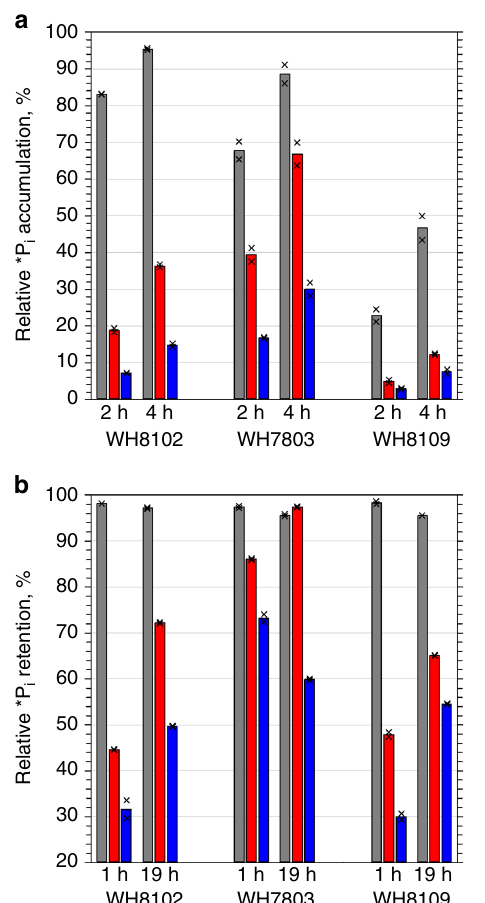
Fig. 4 Accumulation and retention of the accumulated *P i by Synechococcus . a The total P i accumulated in live cells (grey bars) compared with the amount of P i in PFA- fi xed cellular macromolecules (red bars) and TCA-precipitated nucleic acids (blue bars). Cells washed to remove the free P i were re-suspended in ASW-P i , supplemented with 100 Bq ml − 1 of H 3 32 PO 4 , incubated under standard cultivation conditions and sampled after 2 and 4 h. b Retention of the total accumulated P i in *P i pre- labelled cells and its internalization into macromolecules and nucleic acids. The pre-labelled cells re-suspended in ASW-P i were incubated under standard cultivation conditions and sampled after 1 and 19 h. The plots show the results of representative experiments. Bars present mean values of technical duplicates indicated as crosses. Horizontal grey lines indicate major ticks of the Y-axis to assist comparing values. Source data are provided as a Source Data fi le. (Fig. 7), i.e., ASW diluted 1:10 – 1:100, phosphate-buffered saline P i accumulation by cultured Synechococcus cells, we compared the or DW (Supplementary Table 8), which release periplasmic cell CCCP effect with the effect of three other metabolic inhibitors contents 27,39 but do not cause osmotic cell lysis of marine (Supplementary Table 7) on P i acquisition by oceanic bacter- Synechococcus (Fig. 5). Hypotonic washes reproducibly removed ioplankton to safeguard from potential artefacts. A similar time an amount of * P i less than, or similar to, that removed from the course of P i clearance by the control and 3-(3,4-dichloro-phenyl)- PFA- fi xed cellular macromolecules (Figs. 3 and 7). Thus, 1,1-dimethylurea (DCMU)-treated bacterioplankton demon- resistance to a variety of extracellular treatments (Fig. 6) in strates that DCMU (which reduces photosynthetic electron fl ow conjunction with the hypotonic removal of the accumulated P i and proton extrusion) slows down the microbial P i clearance rate (Figs. 3, 5 and 7) strongly indicates the periplasmic location of the by ~30% (Supplementary Fig. 5). This reduction is consistent accumulated P i . with the percentage (~30%) of cyanobacterial cells within the total bacterioplankton. The other three inhibitors completely terminated P i clearance by bacterioplankton, as no time course was observed (Supplementary Fig. 5). The effect of N,N'-dicy- clohexyl-carbodiimide (DCCD, an ATPase inhibitor) was delayed three times longer compared with 2,5-dibromo-3-methyl-6- NATURE COMMUNICATIONS| (2020) 11:2642